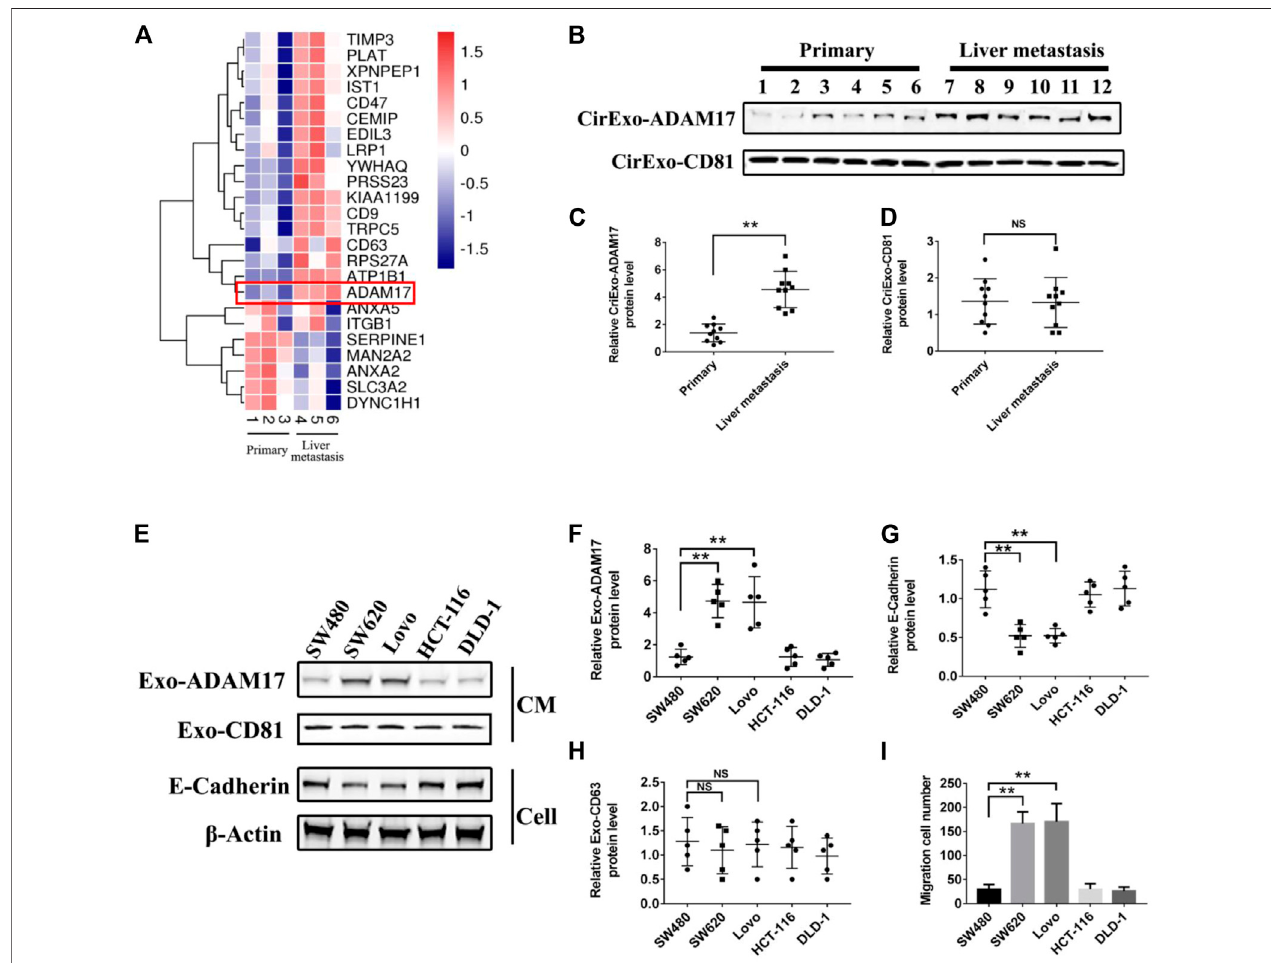
FIGURE 1 | ADAM17 levels in exosomes from CRC patient sera and CRC cell lines. (A) Proteomic analysis of serum-derived exosomal protein differentially expressed between non-metastatic (primary) and liver metastastatic patients with CRC. A heatmap of differentially expressed exosomal proteins based on quantitative mass spectrometry values (technical triplicates, * false discovery rate < 0.05 via ANOVA). Hierarchical clustering (1 — the sample Spearman ’ s rank correlation coef fi cient between observations) was performed on protein expression levels ( n (cid:2) 3). Exosomal ADAM17 was marked with a red frame as a differentially expressed protein. (B) Theserum-derivedexosomes ofnon-metastatic (primary) andlivermetastatic patients withCRC werecollected andlysed foranalysisofADAM17and CD81protein levels. (C,D) The relative protein levels were further calculated via gray analysis (the total exosomal protein was set as the internal control, n (cid:2) 10). (E) SW480, SW620, Lovo, HCT-116, and DLD-1 exosomes and cells were subjected to analysis of ADAM17, CD81, and E-cadherin protein levels (CM, conditioned medium). (F – H) The relative protein levels were further calculated via gray analysis (the total exosomal protein was set asthe internal control for exosomal protein analysis, ß -actin wasset as theinternalcontrolforcells, n (cid:2) 6). (I) Cellmigrationassessment ofSW480,SW620,Lovo,HCT-116, andDLD-1cells via transwellassays( n (cid:2) 6). Dataareexpressedas means ± SDs. *, p < 0.05; **, p <